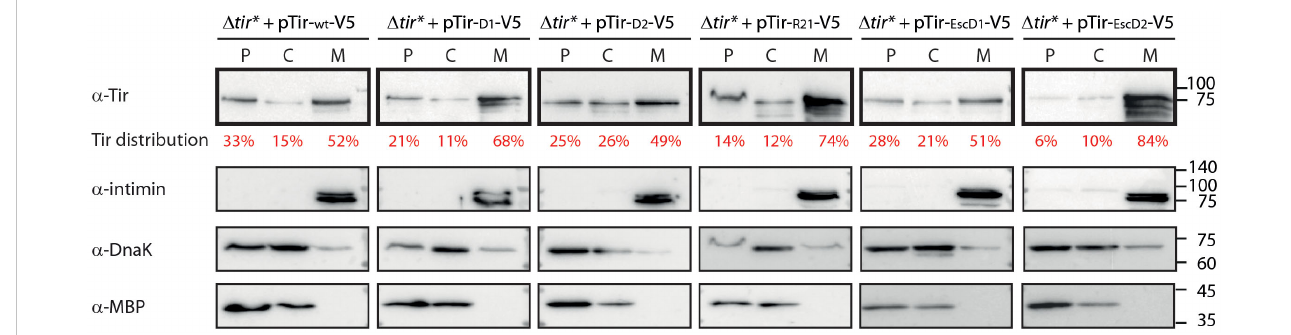
FIGURE 2 Replacement of TMD2 leads to altered Tir localization and enhanced bacterial membrane localization. EPEC D tir * strain expressing Tir wt -V5 or TMD- exchanged Tir variants were grown in calcium-free DMEM to simulate T3SS effector secretion. The bacterial pellets were collected, lysed, and fractionated into periplasmic (P), cytoplasmic (C), and membrane (M) fractions. The samples were loaded on SDS-PAGE and analyzed by western blot using an anti-Tir antibody (blots are marked in bold frames). Tir levels were quanti fi ed by a densitometer, and the percentage of Tir at each fraction is presented in red font under the anti-Tir western blot. To con fi rm correct bacterial fractionation, western blots were also probed with anti-MBP (periplasmic marker), anti-DnaK (cytoplasmic marker), and anti-intimin (membrane marker) antibodies and presented below each bacterial